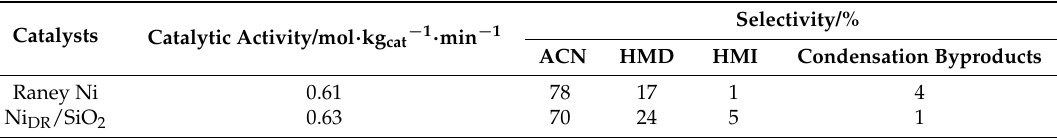
Table 6. Evaluation reaction result of the Ni DR /SiO 2 and Raney Ni.